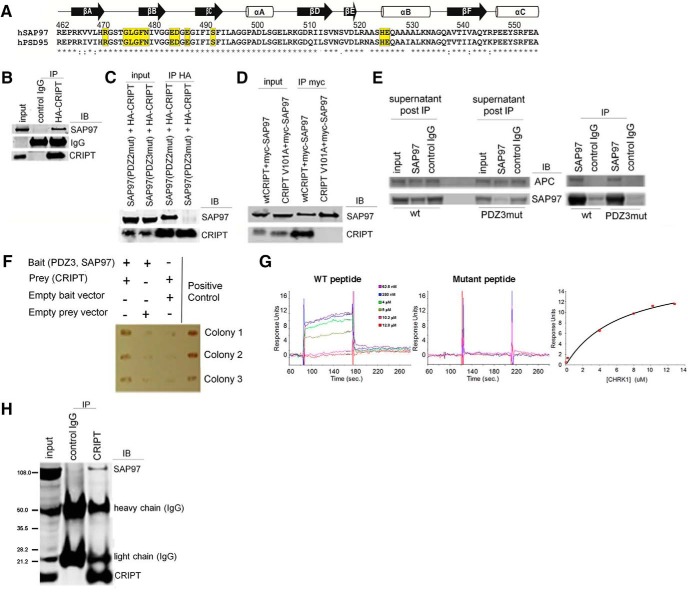

CRIPT is bona fide PDZ3 and SAP97 interacting protein. A, Amino acid sequence alignment of the PDZ3 domains of human SAP97 and human PSD95; there is 86% identity. Residues highlighted in yellow indicate amino acids directly involved in binding the C terminus of CRIPT. Arrows and cylinders above the amino acid sequence indicate secondary structure of the PDZ domain (i.e., βA means beta strand A, αA means alpha helix A, etc.). B, FL myc-tagged SAP97 coimmunoprecipitates with FL HA-tagged CRIPT using the anti-HA antibody when they are overexpressed in HEK293 cells. Neither protein immunoprecipitates with a negative control IgG. C, Overexpressed HA-tagged CRIPT coimmunoprecipitates with myc-tagged SAP97 containing a mutation in the PDZ2 domain (K323A, K326A), but mutation of the PDZ3 domain (H469A, R470A) disrupts this interaction. D, Overexpression of myc-tagged FL SAP97 and FL WT CRIPT or FL CRIPT V101A in HEK293 cells and immunoprecipitation SAP97 using myc IgG. Mutating the PDZ3-interaction motif of CRIPT (CRIPT V101A) abolishes the interaction between SAP97 and CRIPT. E, anti-SAP97 (but not a control IgG) immunoprecipitates WT or PDZ3 mutant version of SAP97 equivalently from cell lysates, as revealed by assay for supernatant after IP. FL SAP97 interacts with FL APC protein in HEK293 cells, but this interaction does not rely on a ligand-binding PDZ3 domain in SAP97. F, FL CRIPT interacts with the PDZ3 domain of SAP97 in a Y2H assay. G, SPR shows a specific and saturable interaction between the 18 C-terminal amino acids of CRIPT and the PDZ3 domain of SAP97 (Kd of 6.57 μM), but no interaction when the CRIPT V101A mutation is present. Values shown were subtracted by a negative control GST peptide. H, Endogenous CRIPT and endogenous SAP97 coimmunoprecipitate in lysates prepared from DIV14 mixed spinal cultures. Immunoblotting of endogenous SAP97 and CRIPT proteins in input lysate and immunoprecipitations using a negative control IgG and CRIPT IgG. Blot was incubated with SAP97 and CRIPT antibody simultaneously.